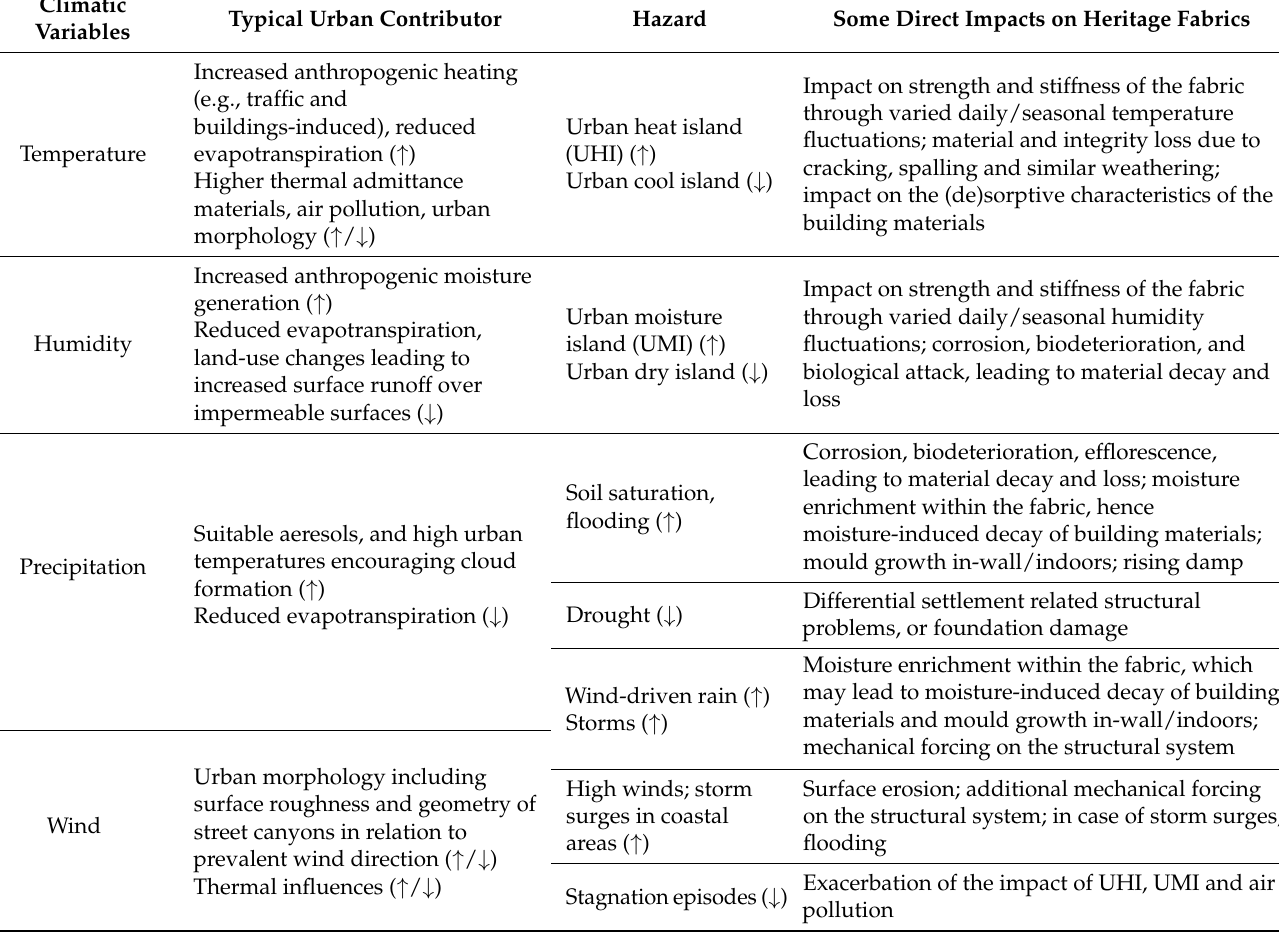
Table 1. A brief summary of the main climatic variables affected by global climate change, typical urban contributors affecting the impact of a given climatic variable, the resulting hazard, and some direct impacts of these on heritage fabrics. The arrows indicate how each listed urban contributor will typically affect a given climatic variable (second column) and the trends leading to each hazard (third